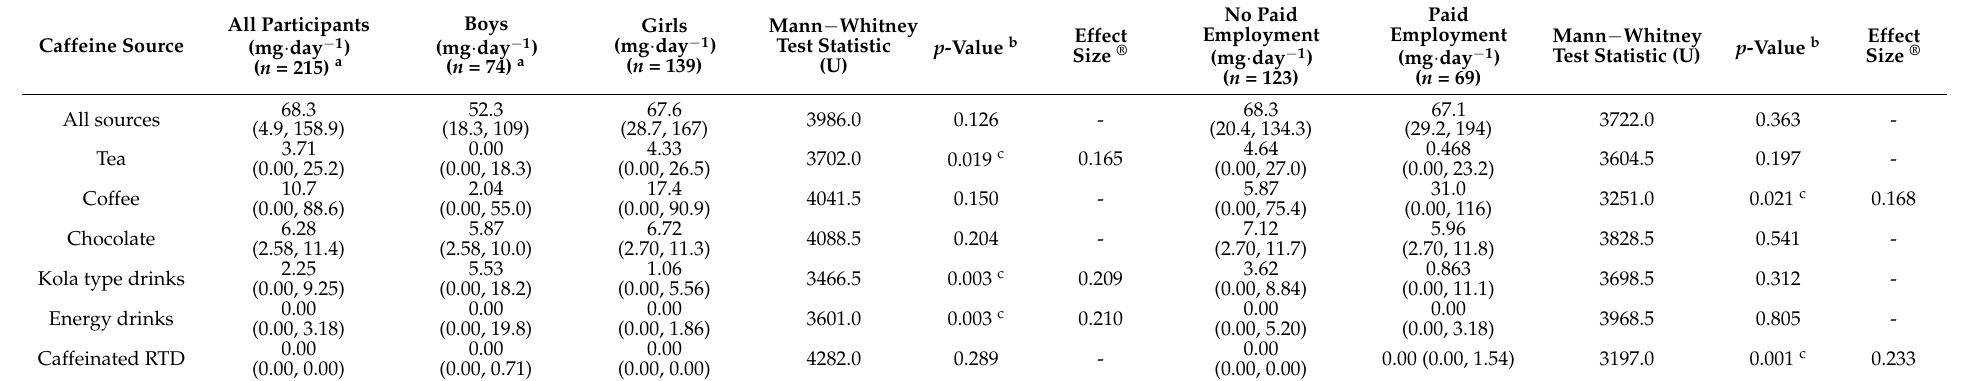
Table 3. Daily caffeine intake based on source by gender and employment